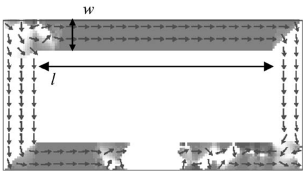
Figure 10. The magnetic configuration of the yoke after saturation and decrease to zero external field as obtained from micro ‐ magnetic simulation [63].